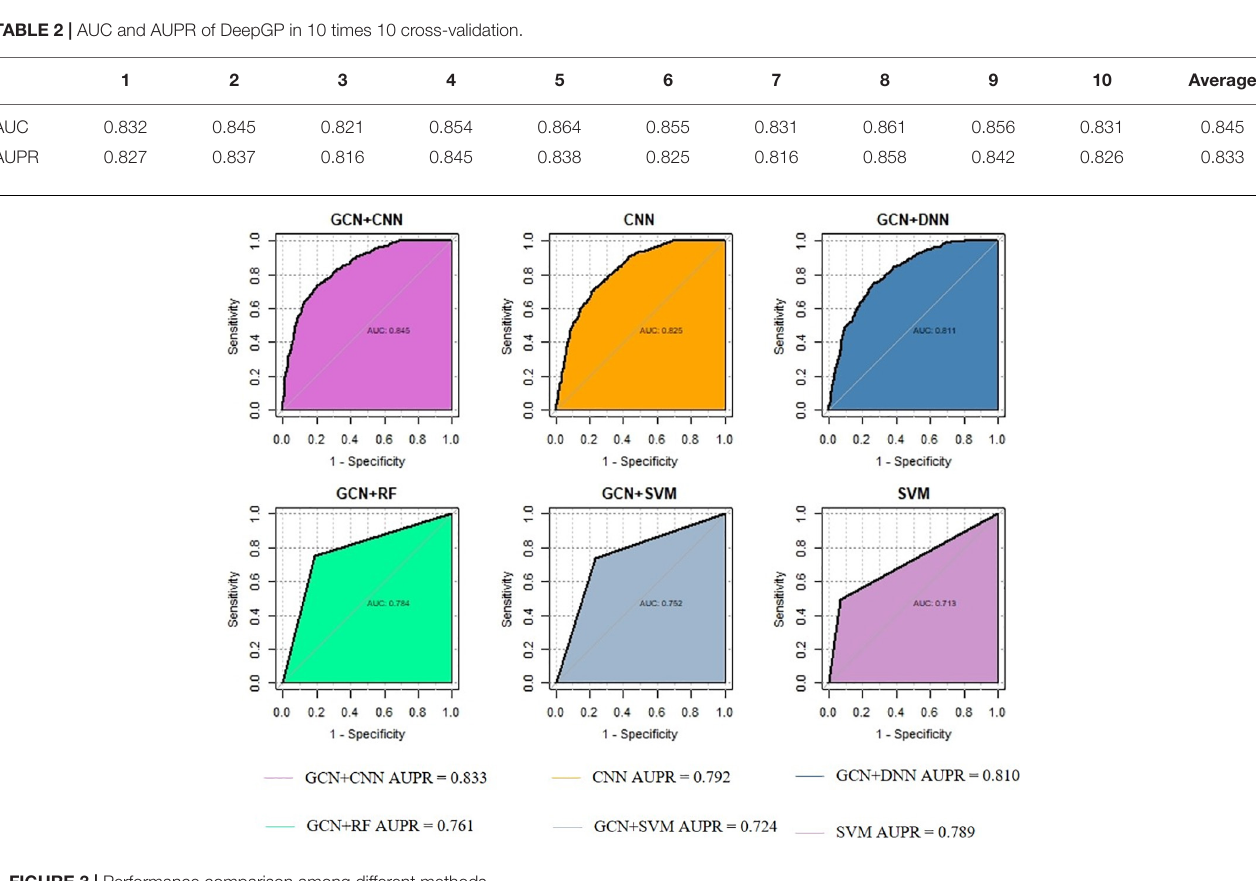
FIGURE 3 | Performance comparison among different